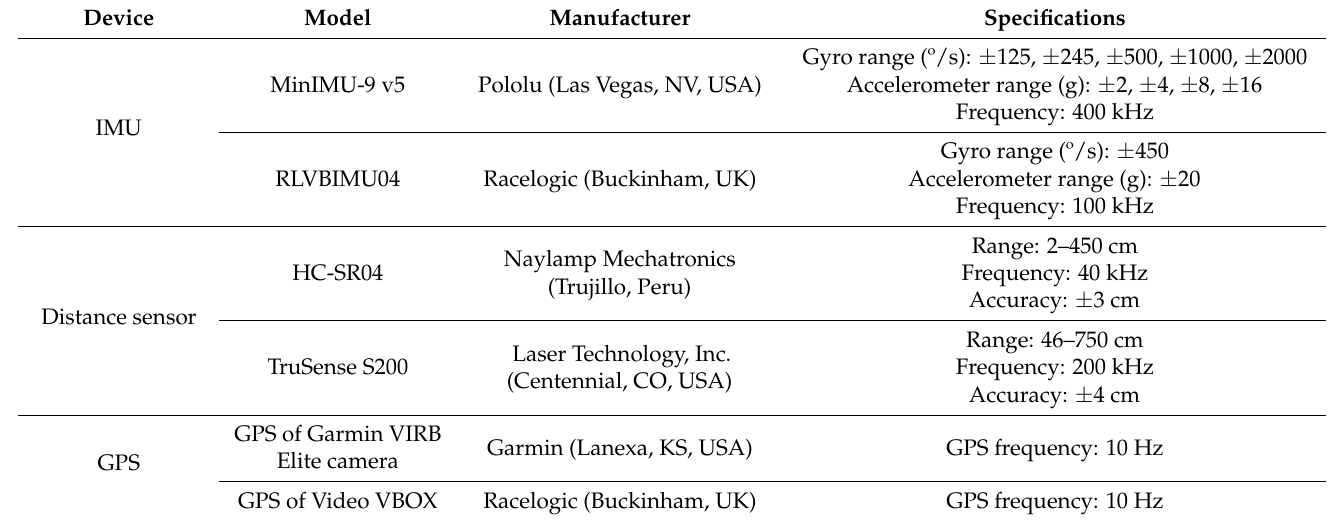
Table 5. Sensor specifications